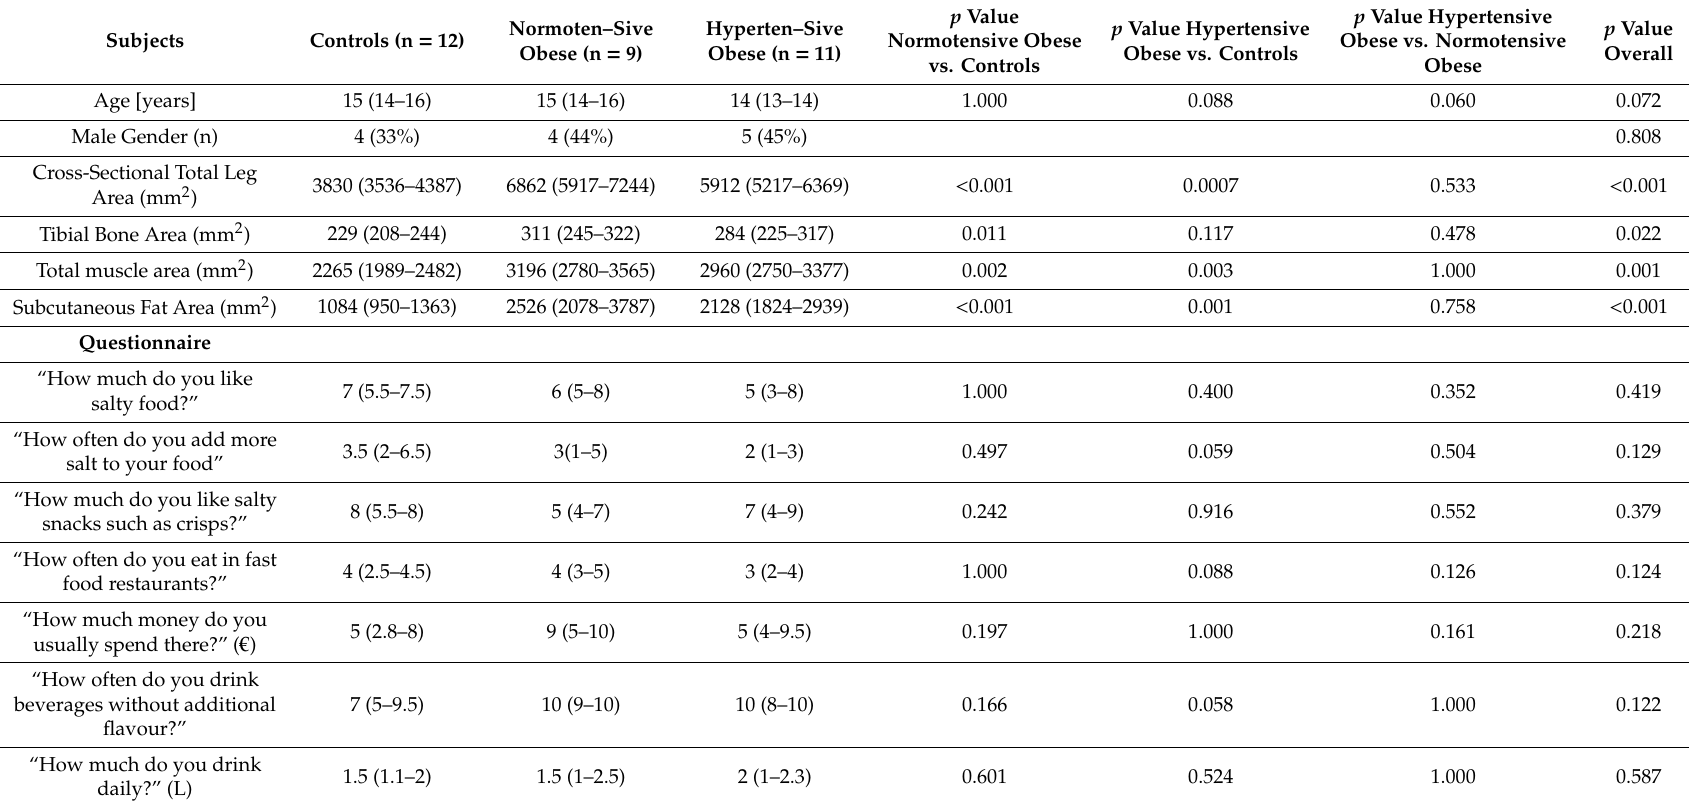
Table 1. Baseline characteristics. Median (interquartile range), unless stated